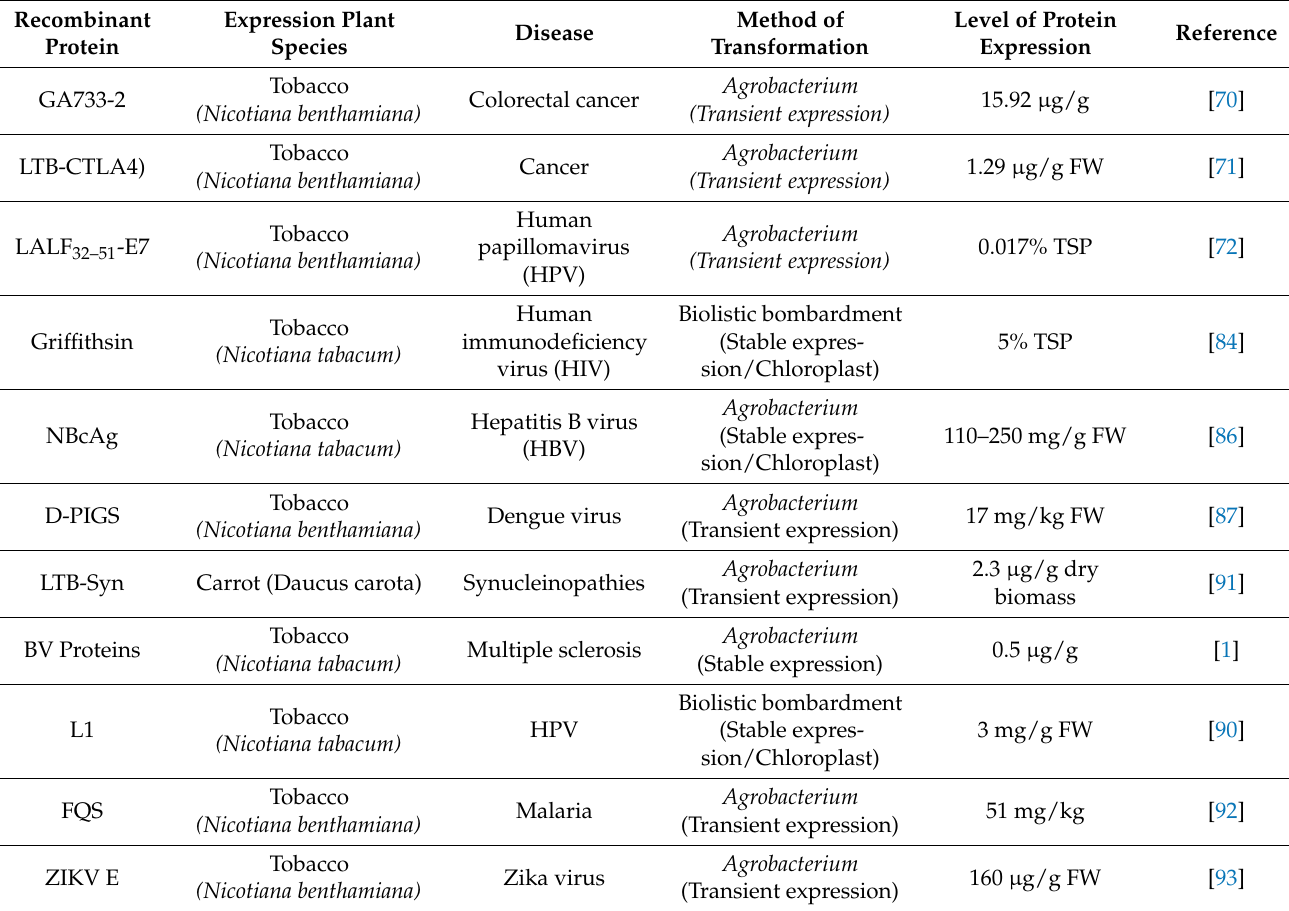
Table 3. Some plant-made vaccine candidates produced over the past 5 years